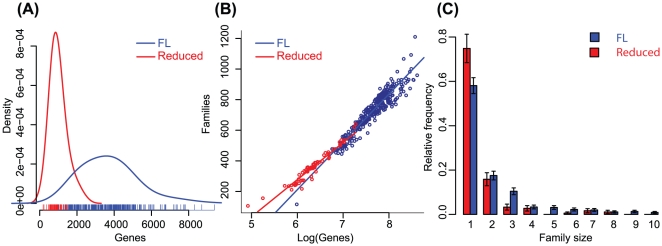
Reduced paralogy in reduced genomes.(A) Genome size distribution in FL (Blue) and Reduced (Red) bacteria, measured as number of genes. We computed a density function (solid lines), and the short colored lines on the x-axis represent the individual genomes. The data set of 69 Reduced genomes has significantly fewer genes (990±439) than the free-living set of 308 genomes (3695±1479: p<2.2.×10−16, Mann-Whitney U test). (B) Reduced genomes have a higher number of families per gene than FL. Solid lines represent a fit by a logarithmic function (r2 = 0.95). The slopes are statistically different (p<4.3×10−7) (C) Reduced genomes have a higher number of singletons and smaller number of protein families with more than one element. These distributions are significantly different (p = 0.00018, χ2 homogeneity test on absolute frequencies). Note that because of the variability of the size of the families in different genomes, we subjected it to a high pass filter (see methods).